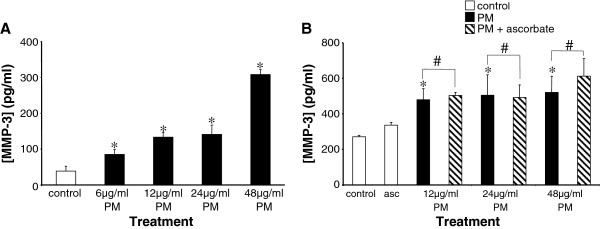
 PM-induced MMP-3 elevation occurs independently of oxidative stress. A, PM induced a concentration-dependent increase in MMP-3 levels. Data are mean ± S.D. MMP-3 levels were assessed by electrochemiluminescence in supernatants taken from treated cells. n = 6 in each case. *p < 0.05 compared to controls. B, PM-induced MMP-3 expression was not affected by ascorbate pre-treatment. n = 6 in each case. *p < 0.05 compared to controls. #, p > 0.05 compared to TPM alone.